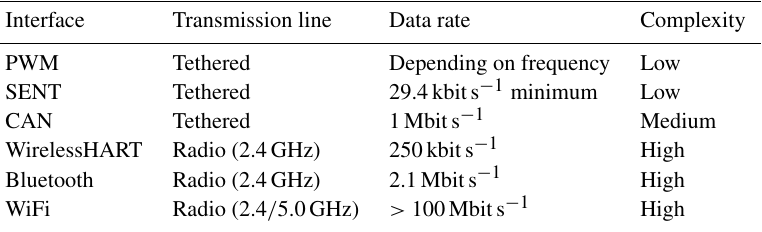
Table 1. Commonly used sensor